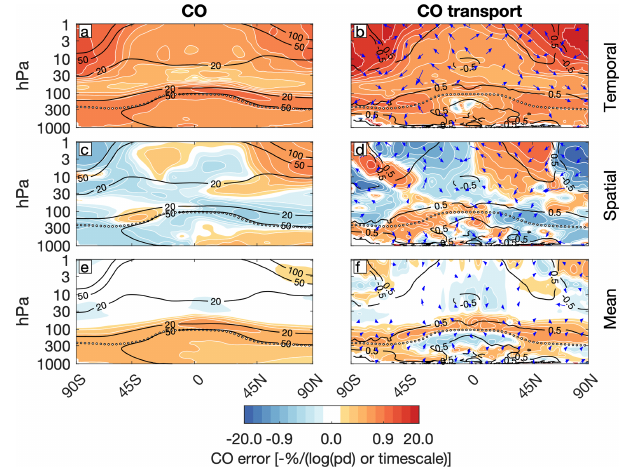
Figure 15. As in Fig. 14 but for carbon monoxide and based on the projections in the right column of Fig. 16.